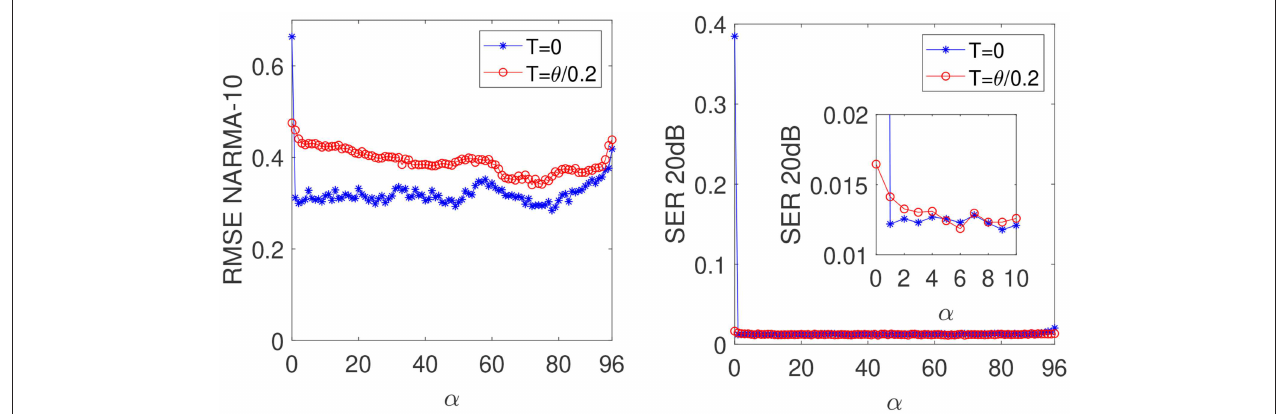
FIGURE 8 | Performance of the non-linear one delay-based RC for two tasks as function of α . Left : NARMA-10 for γ = 0.1. Right : Equalization with SNR = 20 dB and γ = 1. The blue stars correspond to the case of T = 0 and the red circles to the case of T = θ/ 0.2.